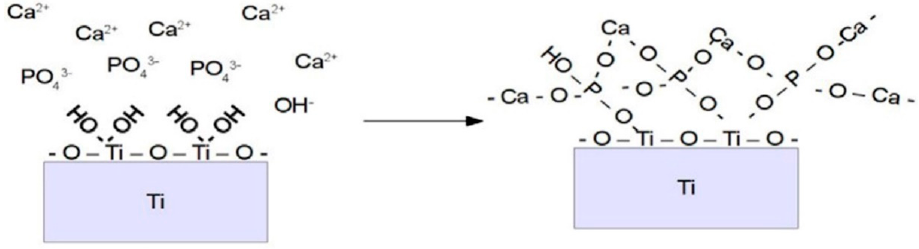
Figure 6. Schematic view of bonding Hydroxyapatite on the Titanium surface [16].